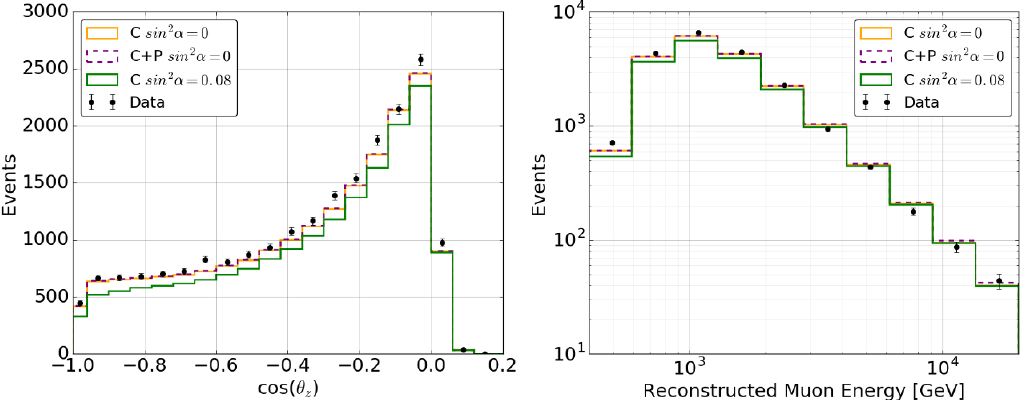
Figure 4 . Zenith angle (left panel) and neutrino energy (right panel) distributions of IC86 neutrino event data [37] and models. The models shown are for conventional (C) atmospheric (cid:13)ux-only and without (with) (cid:23) s mixing using orange (green) continuous histogram; and for conventional+prompt (C+P) atmospheric (cid:13)ux and without (cid:23) s mixing using magenta dashed